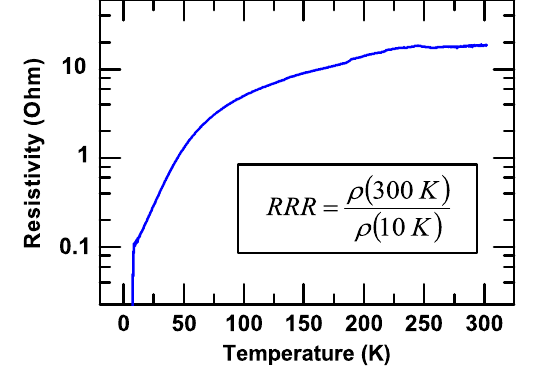
FIG. 8. Resistivity as a function of temperature in a 600 nm, single crystal Nb ð 001 Þ = MgO ð 001 Þ